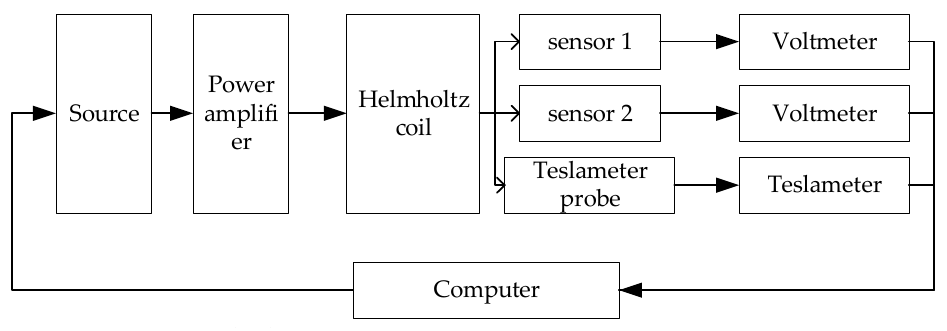
Figure 4. Experimental scheme.